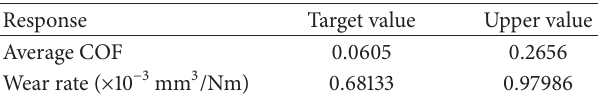
Table 11: Target value and upper value of average COF and wear